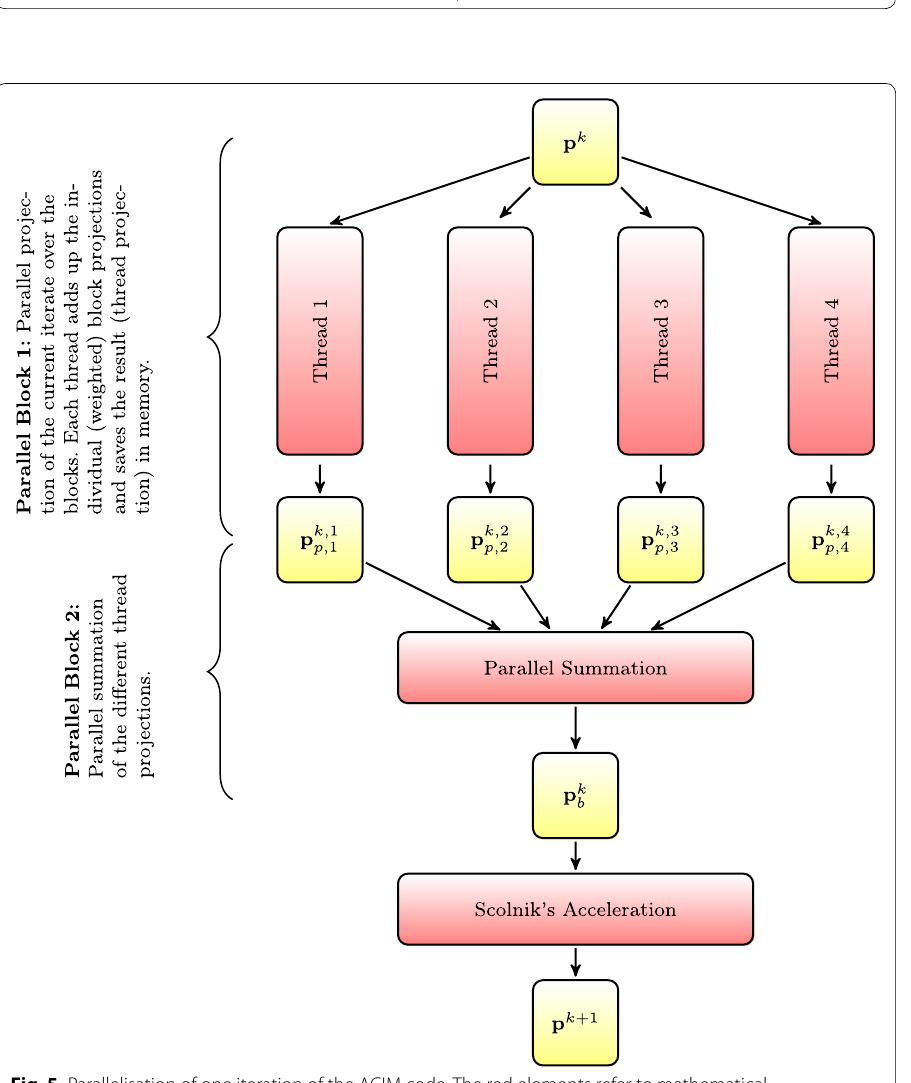
Fig. 5 Parallelisation of one iteration of the ACIM code. The red elements refer to mathematical manipulations, and the yellow elements represent variables. Parallel Block 1 calculates the thread projections in parallel. In Parallel Block 2, the individual thread projections are added up in parallel to form the